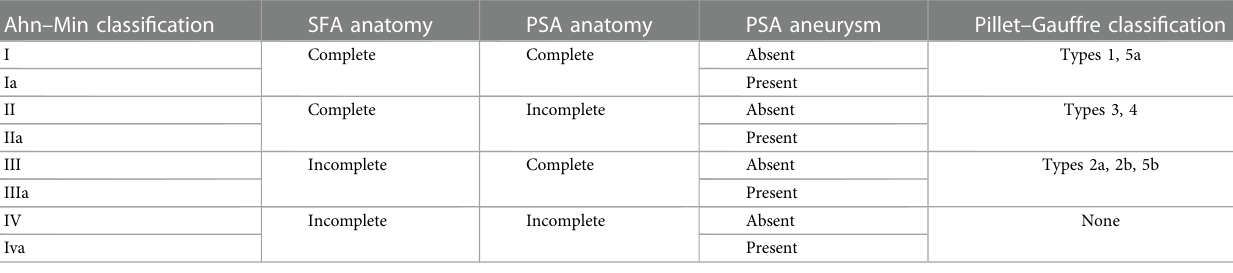
TABLE 1 Comparison of the Ahn – Min and Pillet – Gauffre classi fi cations based on the completeness of the PSA and SFA. Ahn – Min classi fi